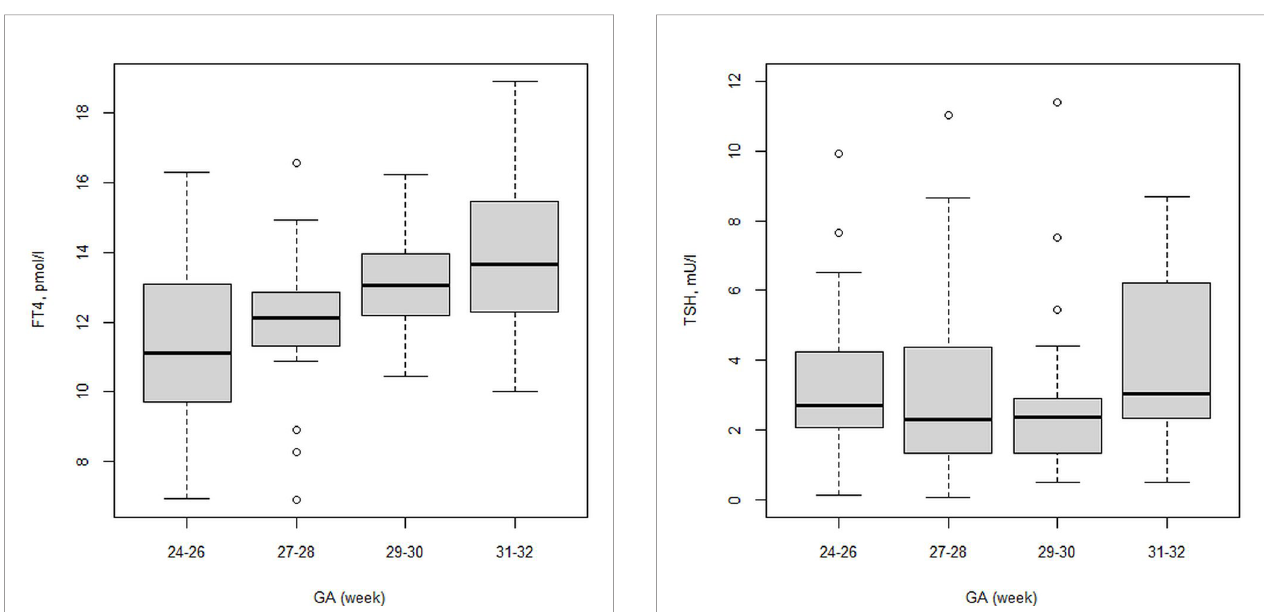
FIGURE 2 | Boxplot showing the distribution of FT4 (pmol/l) level. FIGURE 3 | Boxplot showing the distribution of TSH (mU/l) level.